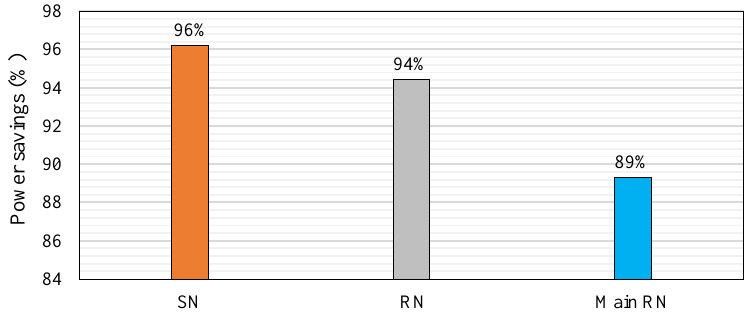
Figure 13. Developed power savings of the WSN nodes based on the sleep/wake scheme.